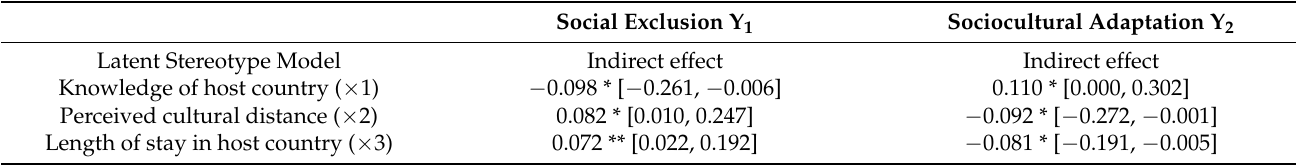
Table 3. Indirect effects of study predictors on social exclusion and sociocultural adaptation in a sample of Chinese sojourner workers in